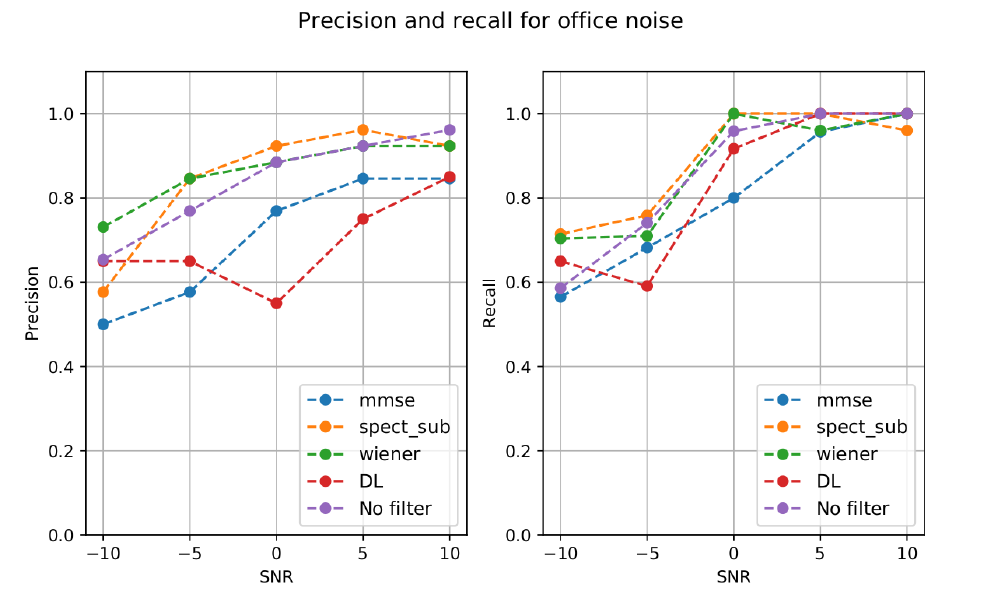
Figure 6. Comparison of Precision and Recall results for Office